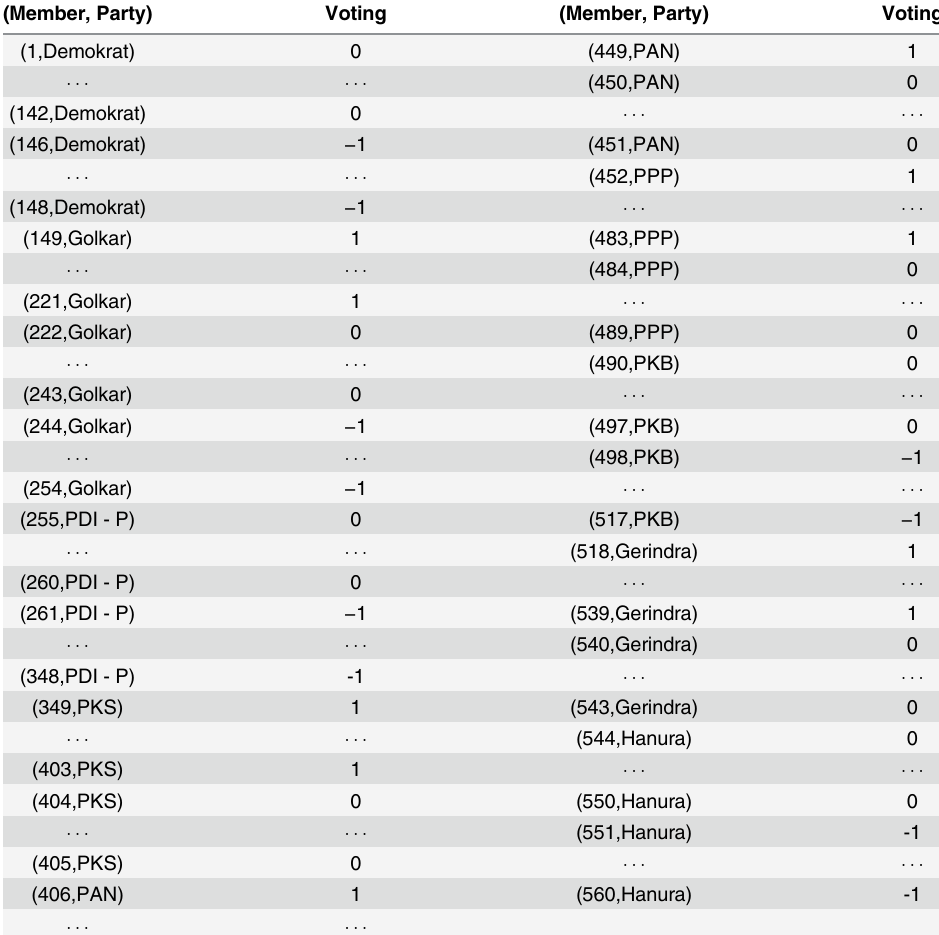
Table 10. Conflict situation with agents ( Member , Party ) and the voting function voting.